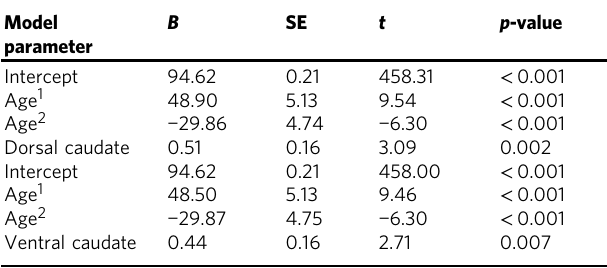
Table 1 Predicting learning performance above a quadratic effect of age from neural sensitivity to informative